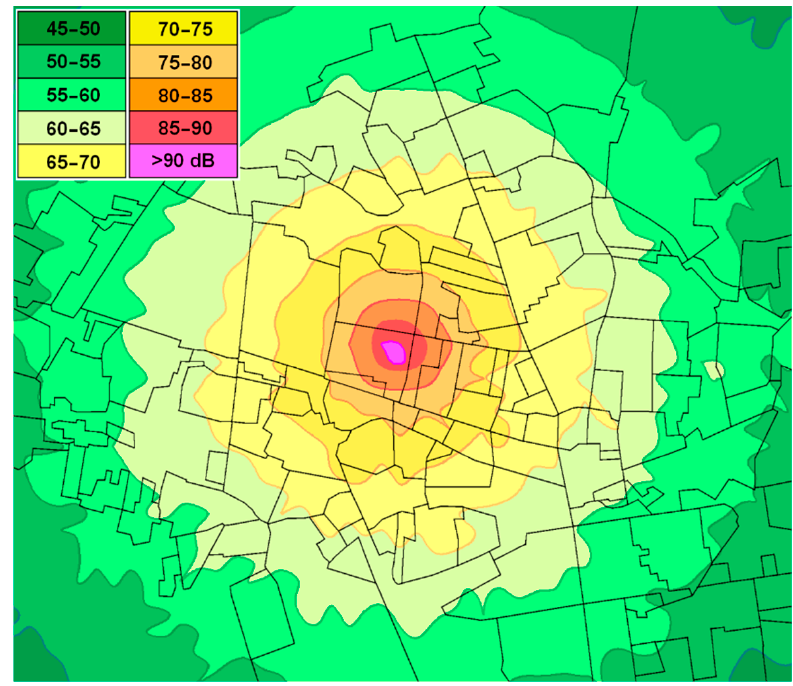
Figure 3. Noise level due to the steam discharge without a silencer use.